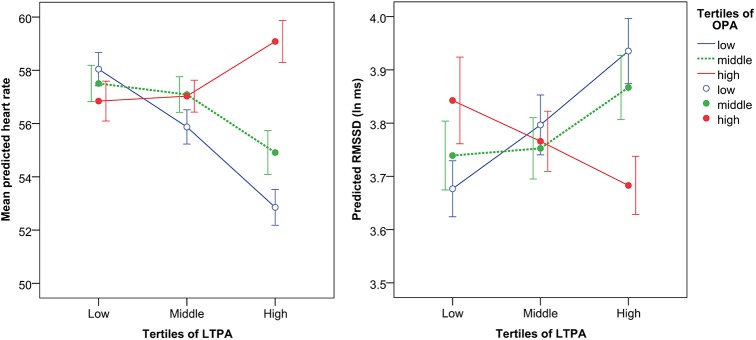
Mean predicted heart rate and RMSSD (parasympathetic index) across tertiles (low, middle and high) of occupational (OPA) and leisure-time physical activity (LTPA).Lines represent tertiles of OPA, and the y-axis represents tertiles of LTPA. Error bars represent 95% confidence intervals.